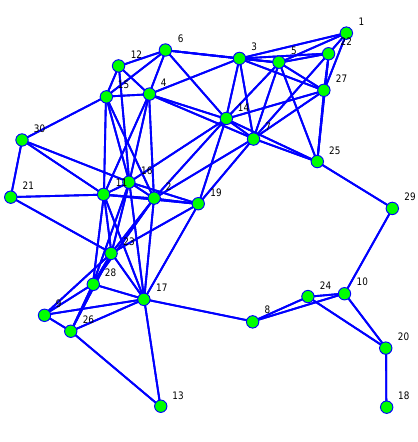
Figure 9. Network topology of 30 agents.